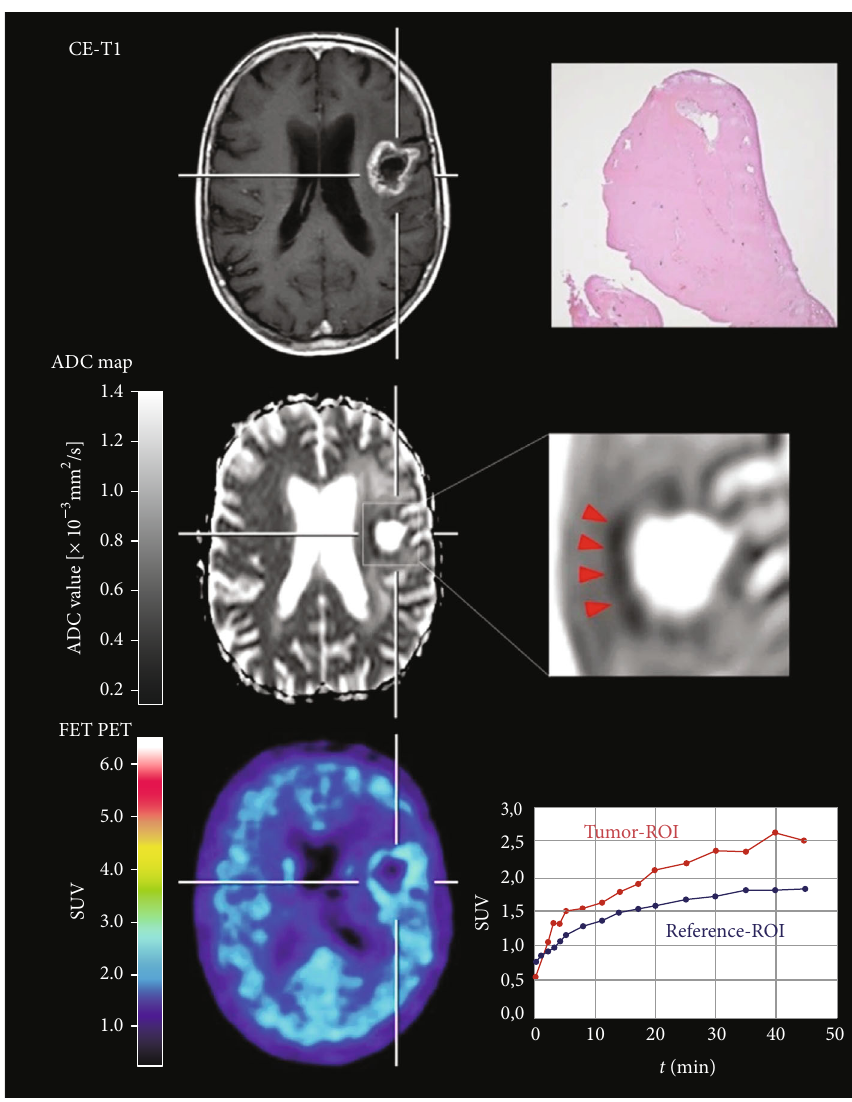
Figure 3: FET PET combined with DWI to detect radiation necrosis (histologically con fi rmed) after glioma treatment. Contrast-enhanced MRI, ADC map obtained from DWI, and FET PET of a 69-year-old female patient with anaplastic oligodendroglioma. Twenty-nine months after fractionated external beam radiotherapy, brachytherapy, and adjuvant temozolomide chemotherapy, contrast-enhanced MRI suggested tumor progression. In spatial correspondence to the contrast enhancement, the ADC map revealed a substantial decrease of di ff usivity in the area of contrast enhancement (arrowheads on the enlarged image; ADC below 0 : 5 × 10 − 3 mm 2 /s ), suggesting tumor progression. In contrast, FET PET showed no increased metabolic activity and a steadily increasing time-activity curve, indicating treatment-related changes. Histological fi ndings obtained following stereotactic biopsy were consistent with radiation necrosis (hematoxylin and eosin staining: original magni fi cation, × 200; scale bar, 50 μ m). For a follow-up time of 6 years, the patient was in a stable clinical condition. Reproduced with permission from Figure 1 of Werner et al.